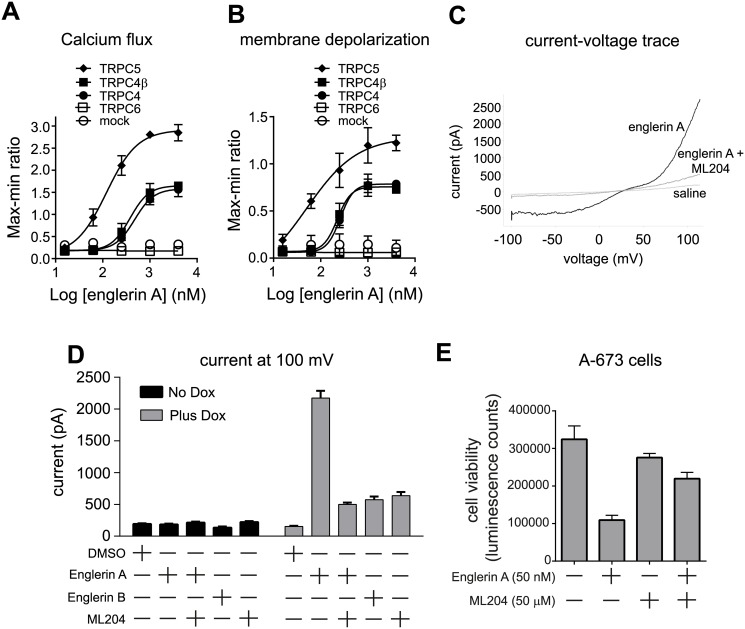
Englerin A agonizes the TRPC4/C5 ion channels and channel activation is needed for cell growth inhibition.(A) Calcium flux stimulated by englerin A in HEK293T cells overexpressing different TRPC proteins (mean +/- standard deviation): TRPC5 (closed diamonds), TRPC4beta (closed squares), TRPC4 (closed circles), TRPC6 (open squares), mock transfected cells (open circles). (B) Membrane depolarization stimulated by englerin A in HEK293T cells overexpressing different TRPC proteins (mean +/- standard deviation), markers as above. (C) TRPC4 current evoked by stimulation of 5 μM Englerin A, saline, or 5 μM Englerin A + 10 μM ML204 in 293T cells with Doxycyline-induced TRPC4. Currents were elicited by 200 ms voltage ramps from -100 to +100 mV, applied every 10 s from holding potential of 0 mV. (D) Summary of englerin A, englerin-B and ML-204 activity on membrane currents (mean +/- S.E.M.) (E) A-673 cell viability in the presence or absence of 50 nM englerin A and/or 50 μM ML204, a TRPC4/C5 channel blocker (mean +/- standard deviation).